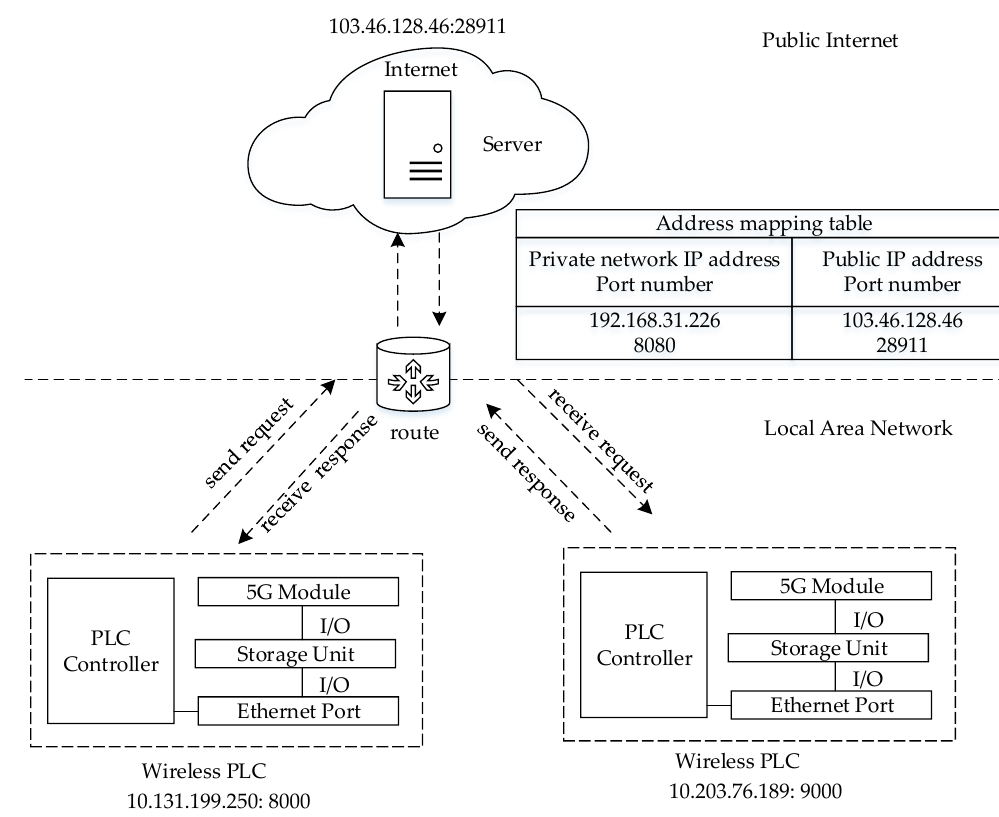
Figure 13. The network address translation of wireless PLC prototype.